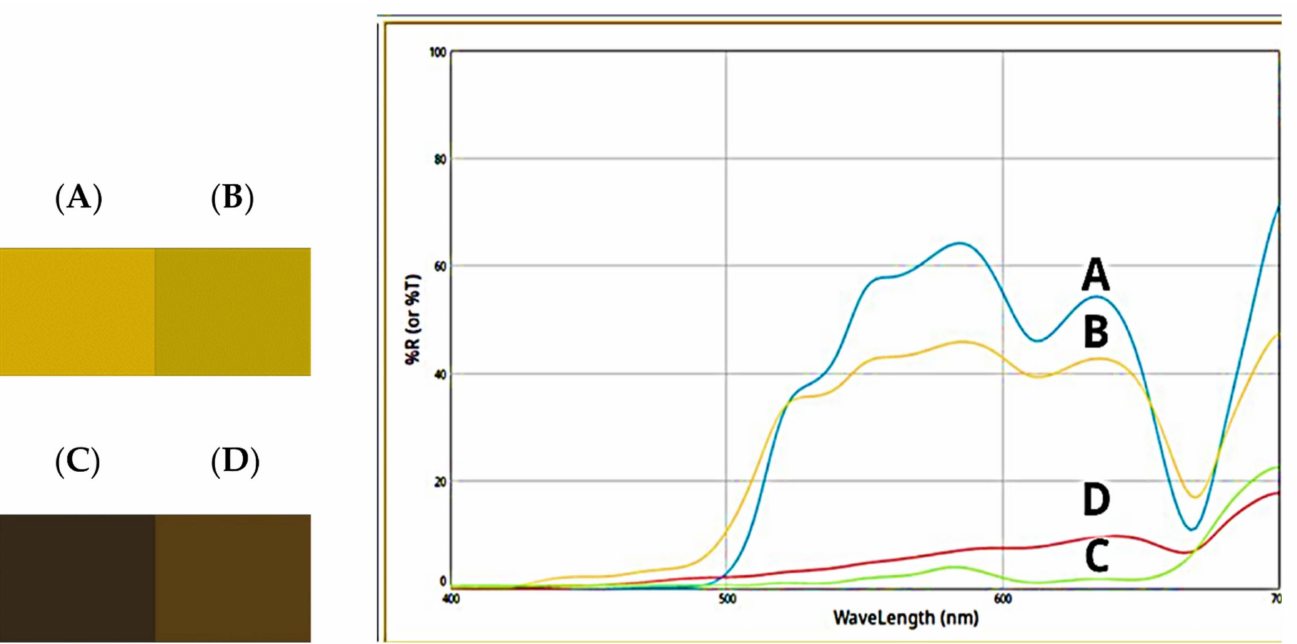
Figure 9. Color palette of olive oil (( A ): t ◦ ; ( B ) t 9 months) and of the formulated product (( C ): t ◦ ; ( D ): t 9 months) and relative reflectance